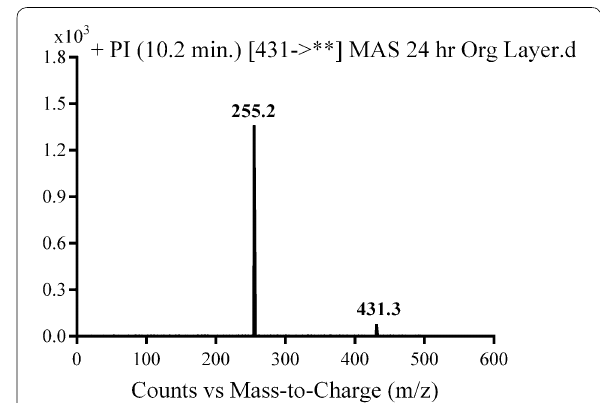
Fig. 13 PI mass spectrum of parent ion (MA1) at m/z